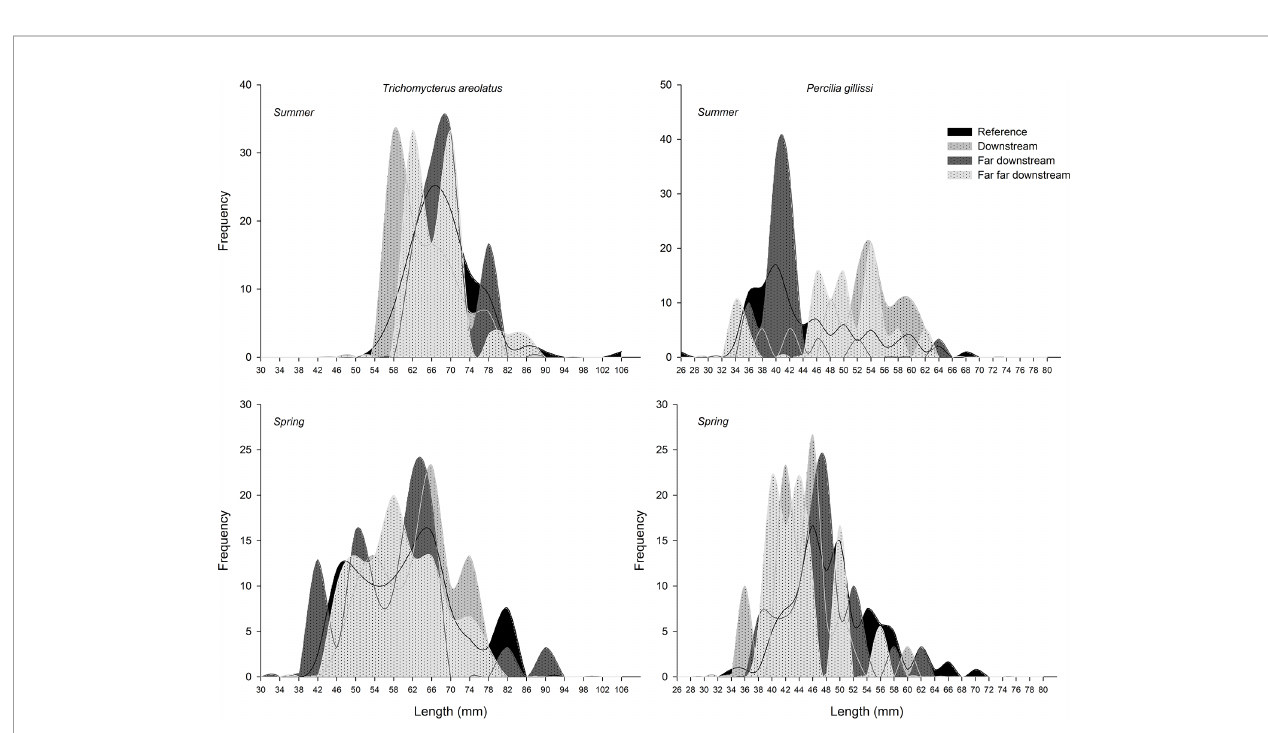
FIGURE 6 | Steroidal hormones 17 b -estradiol (E2) and 11k-testosterone (11-KT) in native fi sh in a river effected by PPME discharge. (nd, non detected).